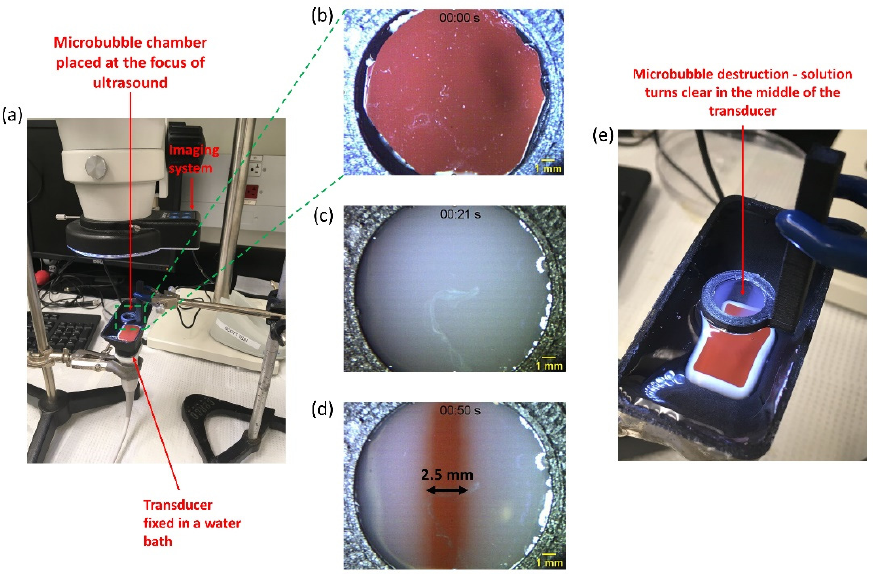
Figure 2. Real time visualization of microbubble cavitation in response to ultrasound exposure. ( a ) Image of the 3D-printed setup for real-time visualization of ultrasound-mediated microbubble destruction. It consists of a 3D-printed water bath fixed on Phillips S3 transducer. A small 3D- printed microbubble chamber is placed at the focus of the transducer. The setup is placed under a microscope for real-time imaging. ( b ) Image of the microbubble chamber before addition of bubbles. The transducer face (reddish-orange color) is visible through the chamber. ( c ) Image of microbubble chamber after addition of bubbles. The solution appears milky due to the presence of microbubbles and the transducer face is barely visible. ( d ) Image of the microbubble chamber after application of ultrasound. The solution turns clear in the centre of chamber and the transducer face becomes visible, indicating destruction of microbubbles in the centre of the transducer. ( e ) Image of the setup during microbubble destruction due to ultrasound.